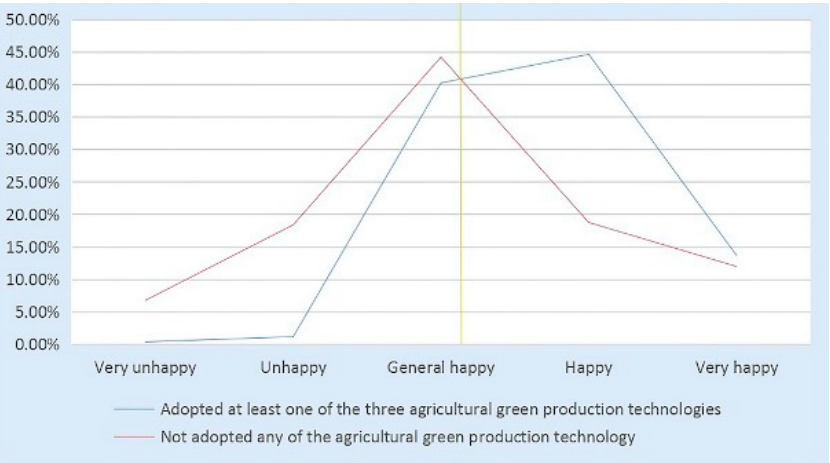
Figure 5. Relationship between adoption of agricultural green production by farmers and their happiness.